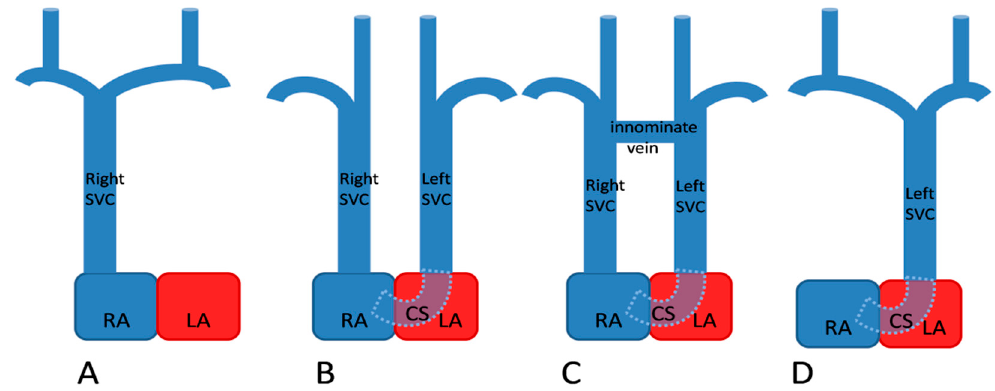
Figure 4. Anatomic types of persistent left superior vena cava (SVC). ( A ) Normal, right-sided SVC ( B ) Double SVC without any anastomosis ( C ) Double SVC with a transverse anastomosis between the two venae cavae ( D ) Left SVC with absent right SVC. Abbreviations: CS, coronary sinus; LA, left atrium; and RA, right atrium (Figure modified from Figure 36.8 in [18]).